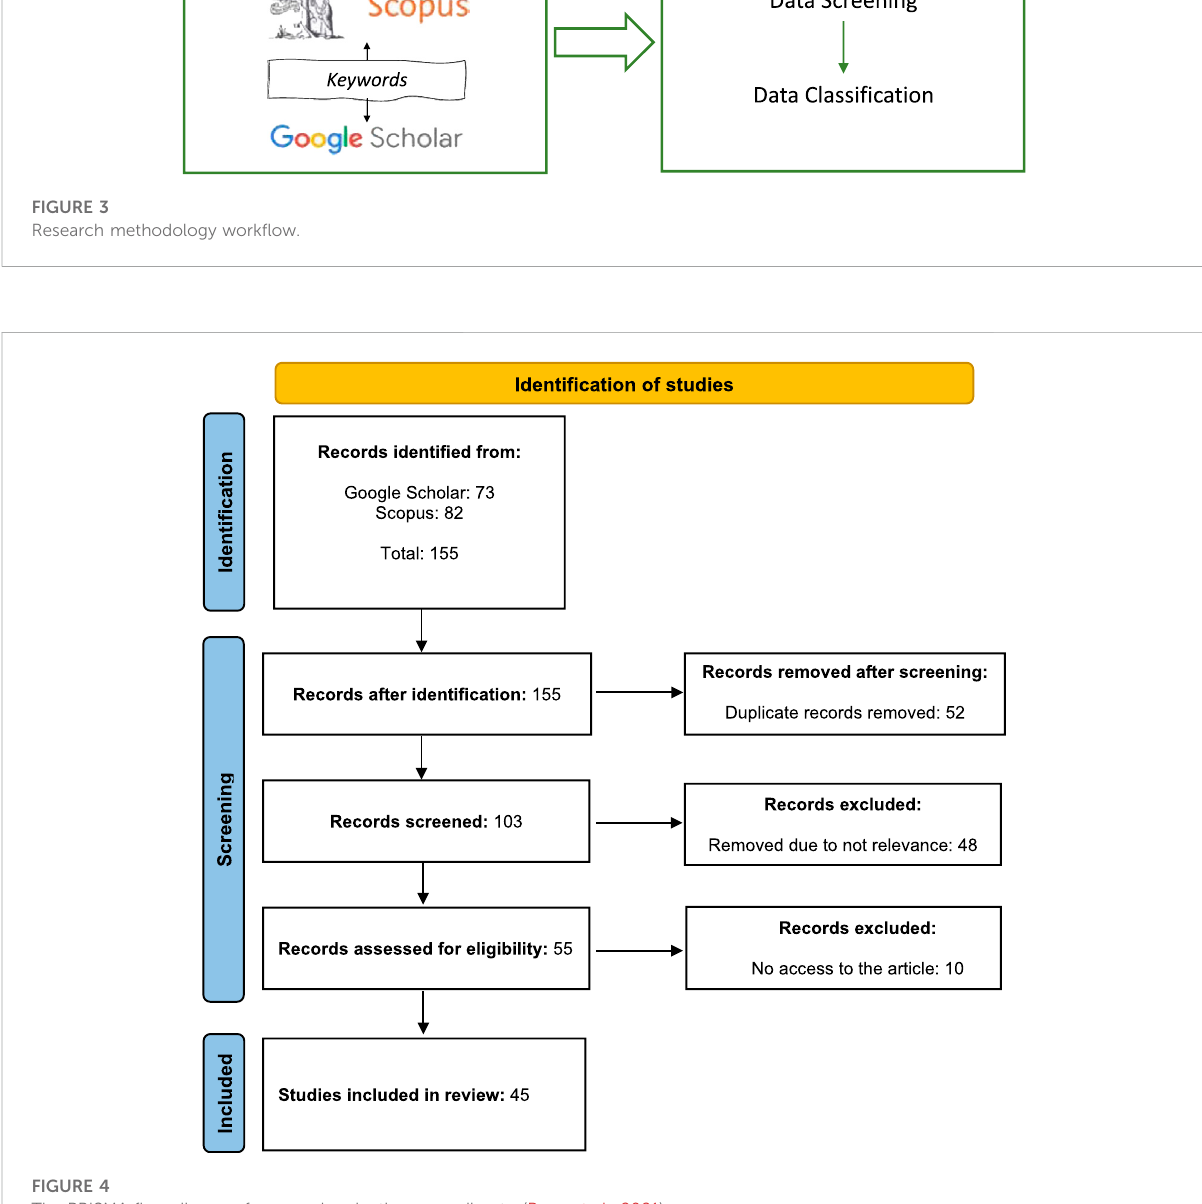
FIGURE 4 The PRISMA fl ow diagram for records selection according to (Page et al.,